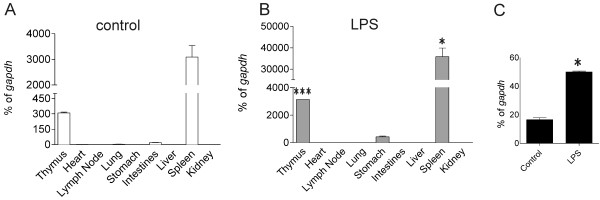
Real time RT/PCR of whole organ cassini expression in control and LPS injected mice. (A, B) Cassini expression in different murine tissues and 5 hrs after I.P. injection with 15 mg/kg E. coli LPS. Expression was verified twice in sets of control and LPS-treated mice (n = 2). Triplicate real-time values are represented as percent of gapdh. *p < 0.05 LPS spleen compared to control spleen. ***p < 0.001 LPS thymus compared to control thymus. (C) Real time RT/PCR on RNA from control and LPS (1 μg/mL) treated splenocytes isolated from a control mouse (n = 1).